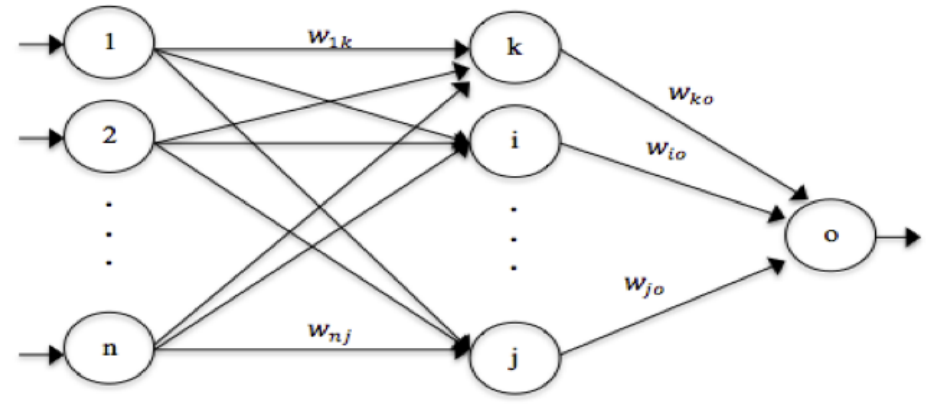
Figure 2. Architecture of the feed-forward neural